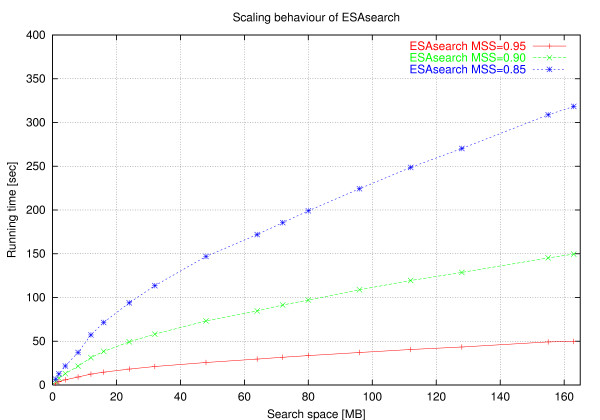
Scaling behaviour of ESAsearch. Experiment 7: Scaling behavior of ESAsearch when searching with 576 TRANSFAC PSSMs on subsets of human chromosome 6 of different sizes and with different matrix similarity cutoff values (MSS). The subsets are prefixes of human chromosome 6 of length 2k for k = 0, 1, 2,..., 7.